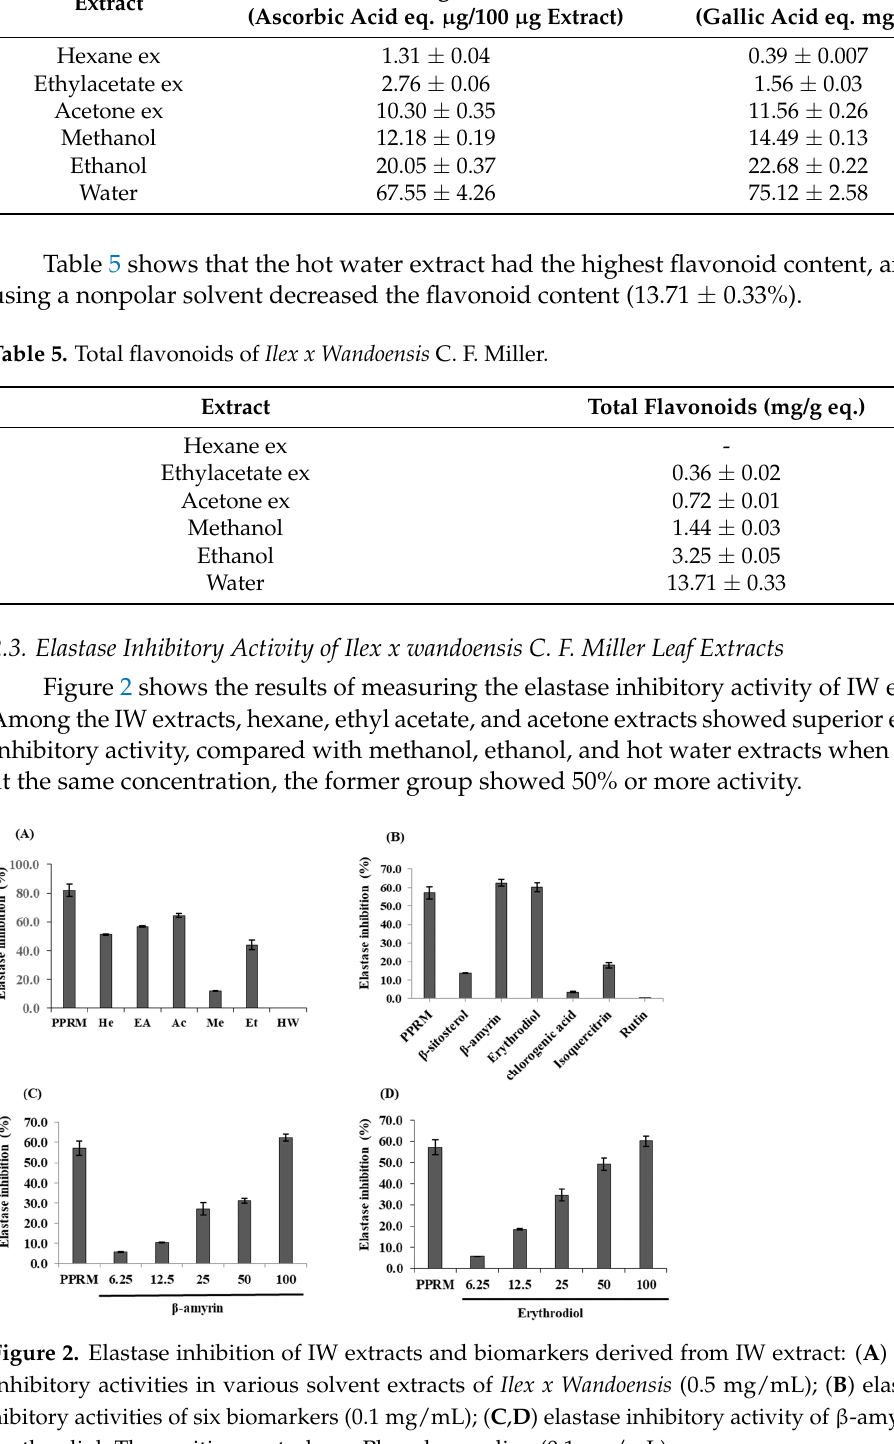
Table 4. Reducing power and total phenolic content of IW extract. Extract